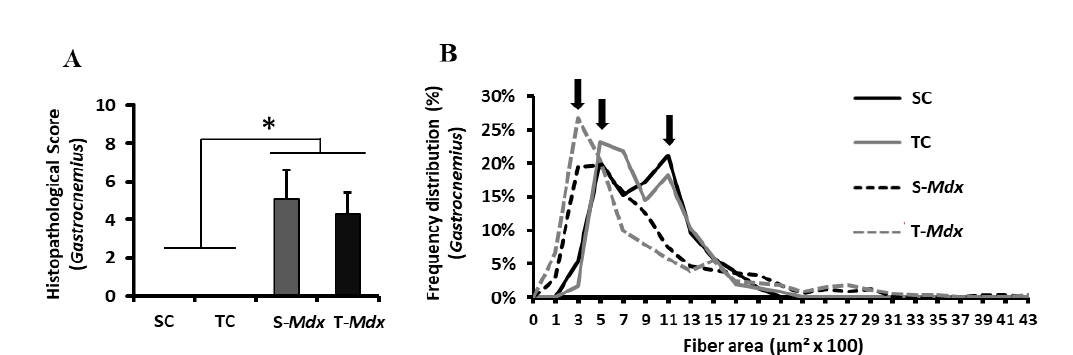
Figure - 2 Histopathological score (A) and muscle fiber cross sectional area frequency distribution (B). The graph (A) shows gastrocnemius histopathological score (Mean + S.D.) of Mdx groups were higher than C groups (*=p<0.05). The graph (B) shows muscle fiber area frequency distribution of gastrocnemius muscle and arrows show peaks of